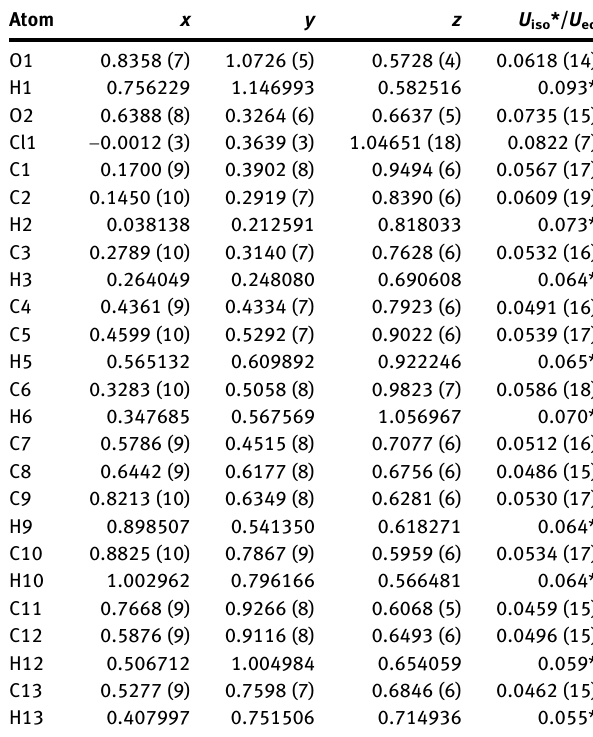
Table  : Fractional atomic coordinates and isotropic or equivalent isotropic displacement parameters (Å 